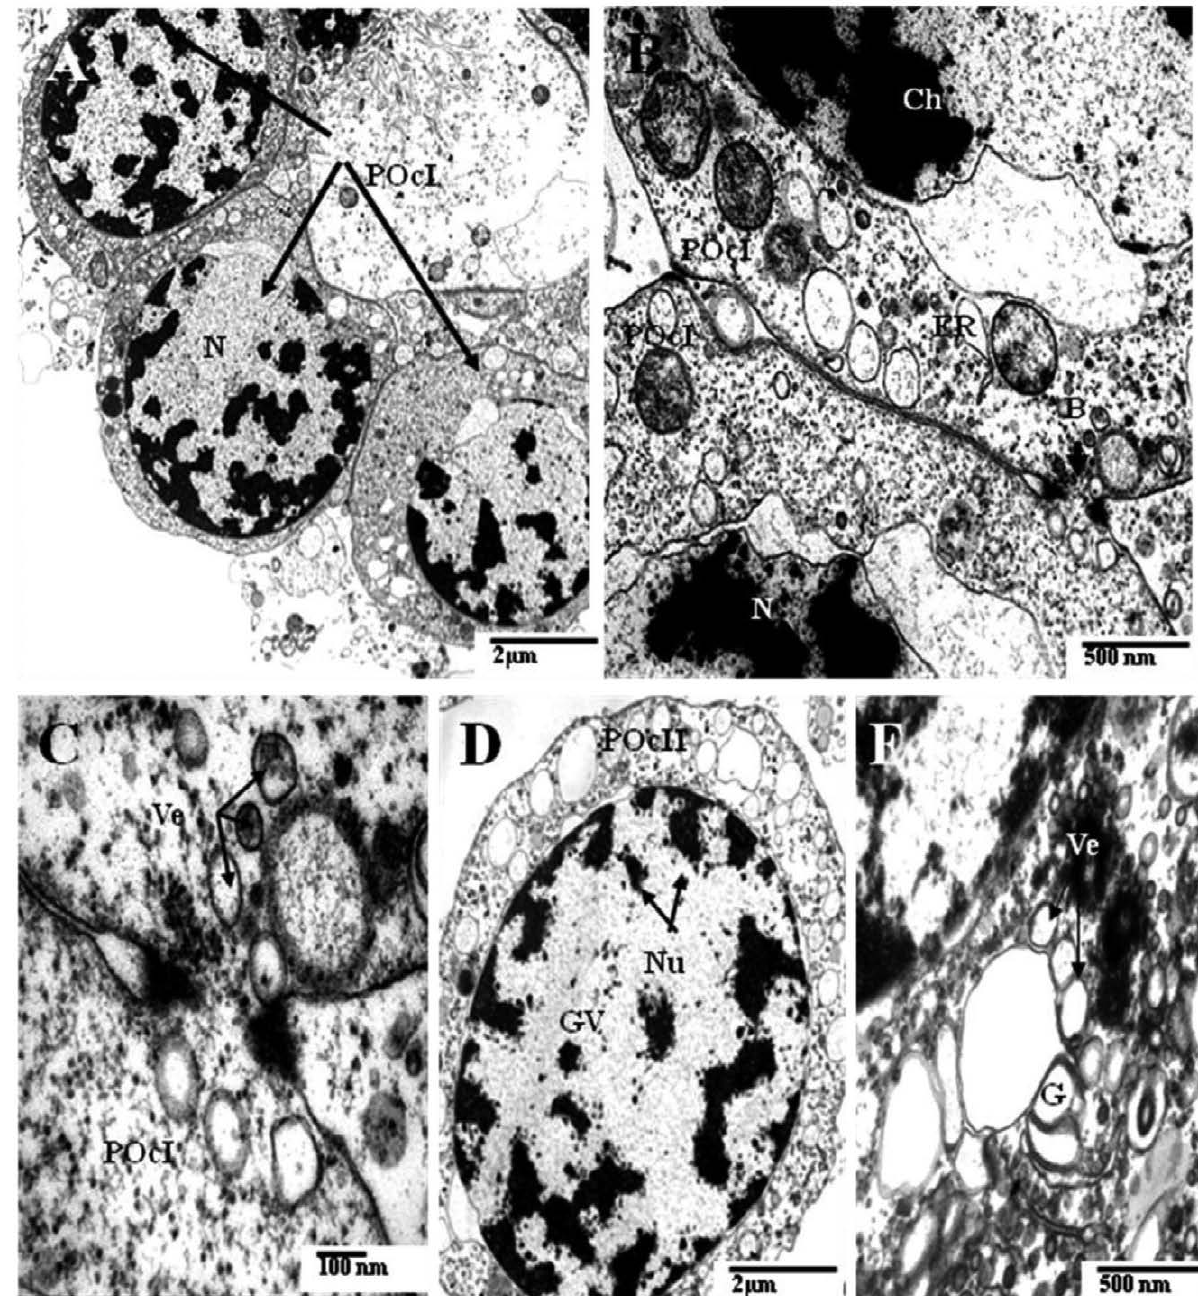
Fig. 3. – A, transmission electron micrograph (TEM) of small premeiotic oocytes I (POcI) (arrows); note large oocyte nuclei (N). B and C, TEM of coelomic cluster of premeiotic oocytes I connected by intercellular bridges (B); D, TEM of premeiotic oocyte II (POcII) showing large germinal vesicle (GV) with micro-nucleoli (Nu) (arrows); E, TEM of premeiotic oocyte II showing small Golgi vesicles (Ve) (arrows) in ooplasm adjacent to the nucleus (N). Ch, chromatin; ER, endoplasmic reticulum; G, Golgi